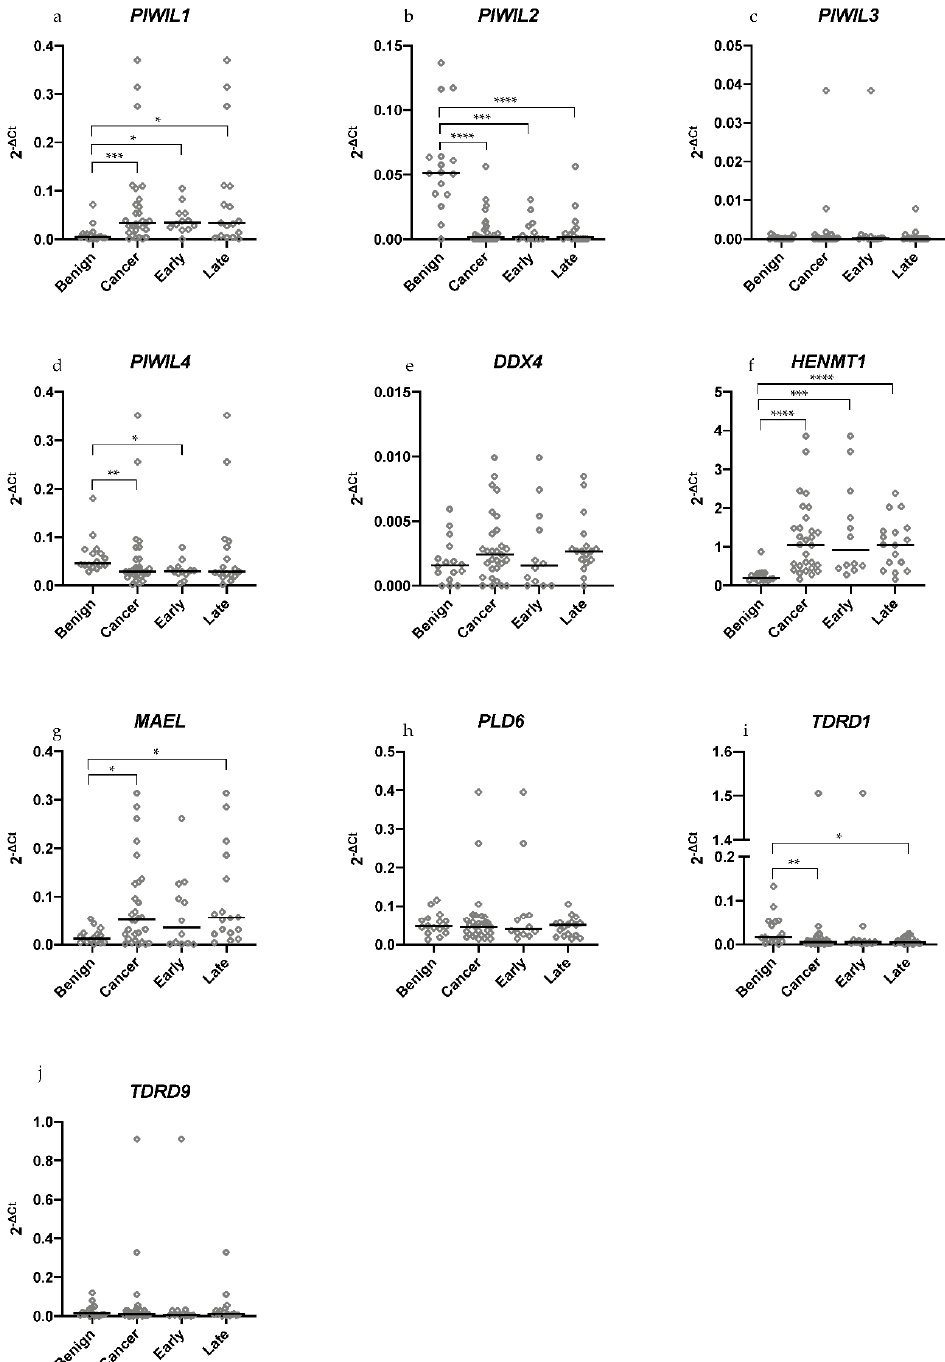
Figure 2. piRNA pathway gene expression in benign serous cystadenoma and high grade serous ovarian cancer (HGSOC) tumors. ( a – d ) Among the 4 PIWIL genes, only PIWIL3 had no significant difference between benign and cancerous tumors. PIWIL1 had increased expression while PIWIL2 and PIWIL4 had decreased expression between benign and cancerous samples. ( e – j ) Comparing expression of benign to cancerous tumors, HENMT1 and MAEL had significantly increased expression while TDRD1 expression was significantly decreased. DDX4 , PLD6 and TDRD9 presented similar expression levels across benign and cancerous tumors. All Ct scores were normalized to the geomean of housekeepers, TBP and GUSB . A median line was used to plot the respective dataset. Benign ( n = 16), cancer (early and late HGSOC, n = 29), early HGSOC (stages 1,2, n = 12) and late HGSOC (stage 3, n = 17). Statistical tests Mann − Whitney U was used to analyze benign versus cancer while Kruskal − Wallis (non-normal distribution) or one-way ANOVA (normal distribution) were used accordingly when comparing expression differences in benign, early and late stage HGSOC. * p < 0.05; ** p < 0.005; *** p < 0.0005; **** p <